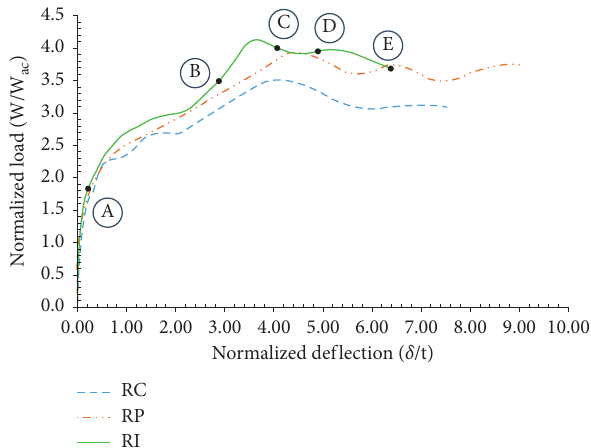
Figure 6: Load-deflection curve in cases RP, RI, and RC (for more clarity, stations A to E are only shown for RI).